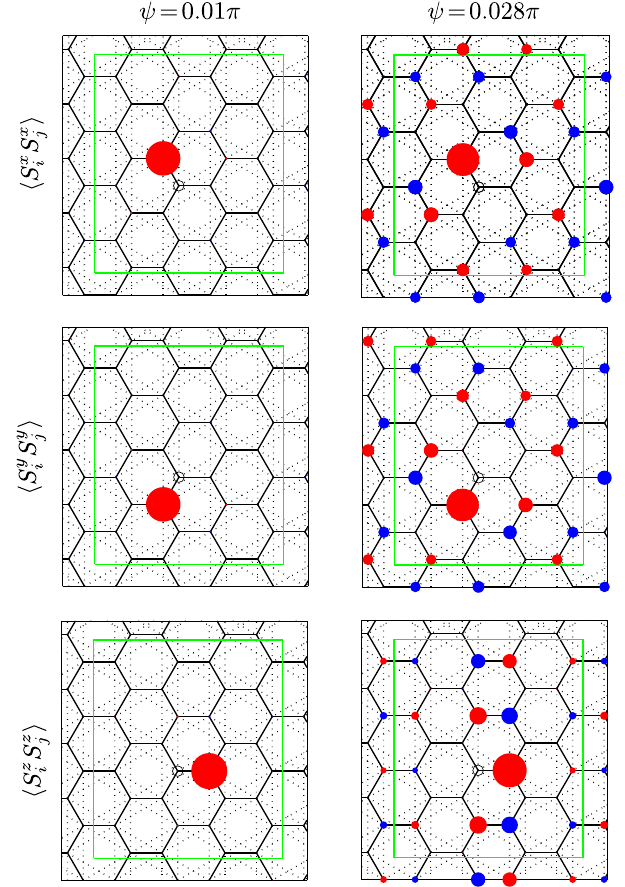
FIG. 4. Real-space spin-spin correlation profiles evaluated at the ground state of the N ¼ 32 cluster, inside the first QSL phase ( ψ ¼ 0 . 01 π , left-hand column) and inside the magnetic phase I ( ψ ¼ 0 . 028 π , right-hand column). Different rows correspond to i , α ¼ x , y , and z . The reference S α the three different channels h S α i j site i is indicated by the small black open circle. Positive (negative) correlations are shown by filled blue (filled red) circles, whose radius scales with the magnitude of the correlation. The difference between α ¼ z and α ¼ x , y stems from the fact that the 32-site cluster does not have the full point-group symmetry of the infinite lattice, and the momentum point M z is not equivalent by symmetry to M and M ; see Ref. x y